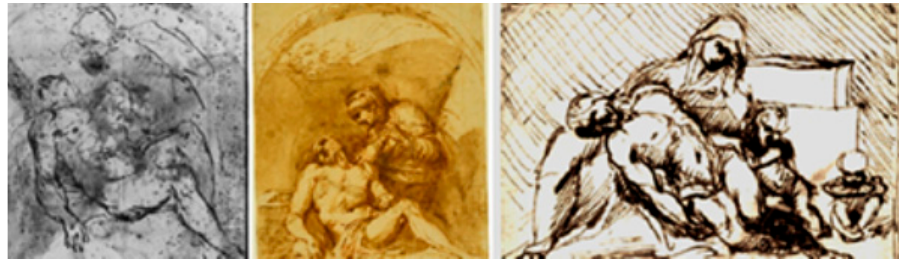
Figure 12. Carraci sketches of his Pietá. A close-up view of three sections.